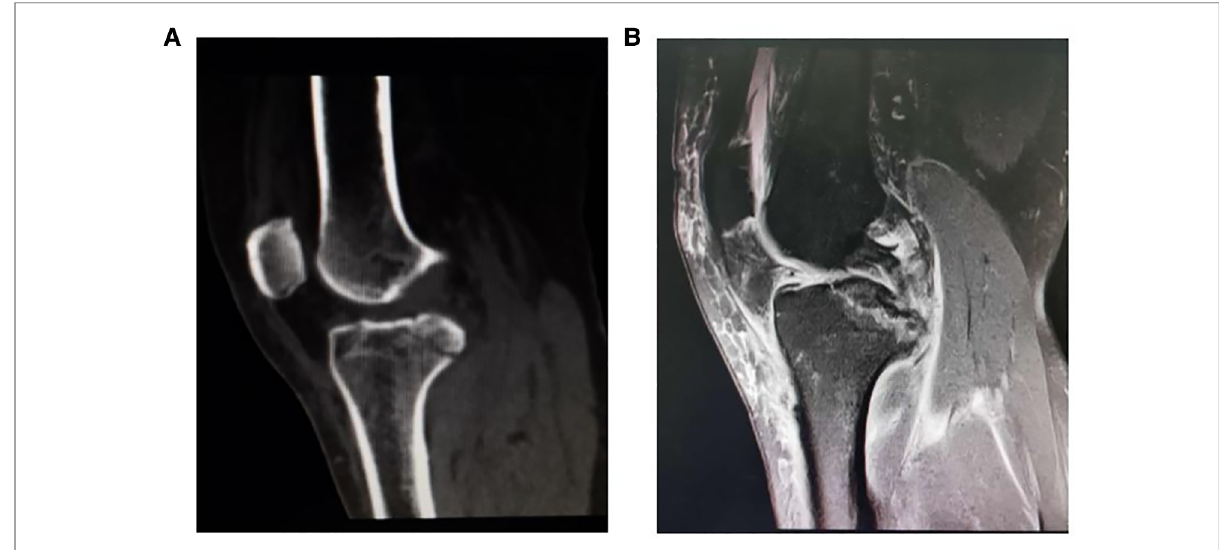
FIGURE 1 Preoperative radiograph of posterior cruciate ligament (PCL) avulsion fracture. ( A ) CT scanning showed the posterior cruciate ligament avulsion fracture. ( B ) MRI con fi rmed the fragment size and displacement of the PCL avulsion